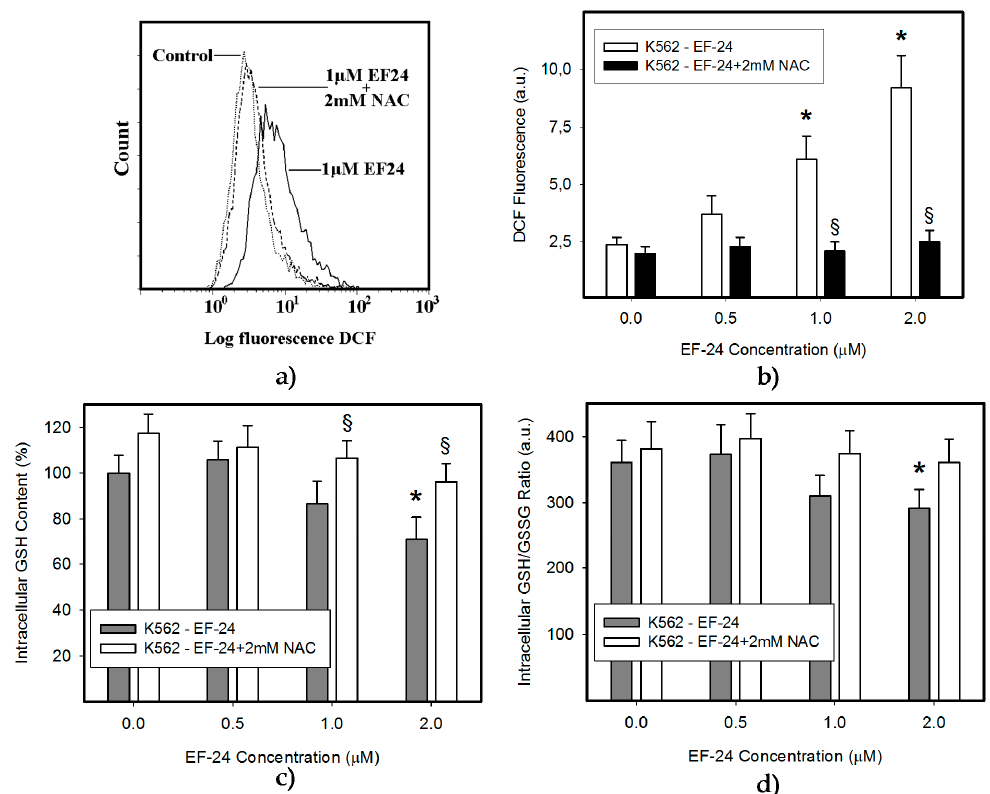
Figure 2. Effect of NAC on EF-24-induced oxidative stress. Cells were treated with EF-24 or with EF-24 + 2 mM NAC, as indicated. The experimental points represent mean values from three replicate experiments, with standard deviations. ( a ) Effect of NAC on reactive oxygen species (ROS) production in EF-24-treated cells. ROS production was determined using flow cytometry after 3 h incubation. A representative analysis. ( b ) A quantitative analysis of the effect of NAC on ROS production in response to EF-24 treatment. ROS production was determined using flow cytometry after 3 h incubation; * denotes significant change in ROS production ( p < 0.05) between control (untreated) K562 cells and cells treated with EF-24; § denotes significant change in ROS production ( p < 0.05) between EF-24 treated K562 cells and cells treated with EF-24 + NAC. ( c ) Effect of NAC on intracellular glutathione (GSH) level in EF-24 treated cells. After 3 h incubation, the intracellular content of GSH was determined using LC/MS/MS analysis; * denotes significant change in the intracellular level of GSH ( p < 0.05) between control (untreated) K562 cells and cells treated with EF-24; § denotes significant change in intracellular level of GSH ( p < 0.05) between K562 cells treated with EF-24 and cells treated with EF-24 + NAC. ( d ) Effect of NAC on GSH/oxidized glutathione (GSSG) ratio in EF-24-treated cells. After 3 h incubation, the intracellular content of GSH and GSSG were determined using LC/MS/MS analysis; * denotes significant change in GSH/GSSG ratio ( p < 0.05) between K562 cells treated with EF-24 and cells treated with EF-24 + NAC.